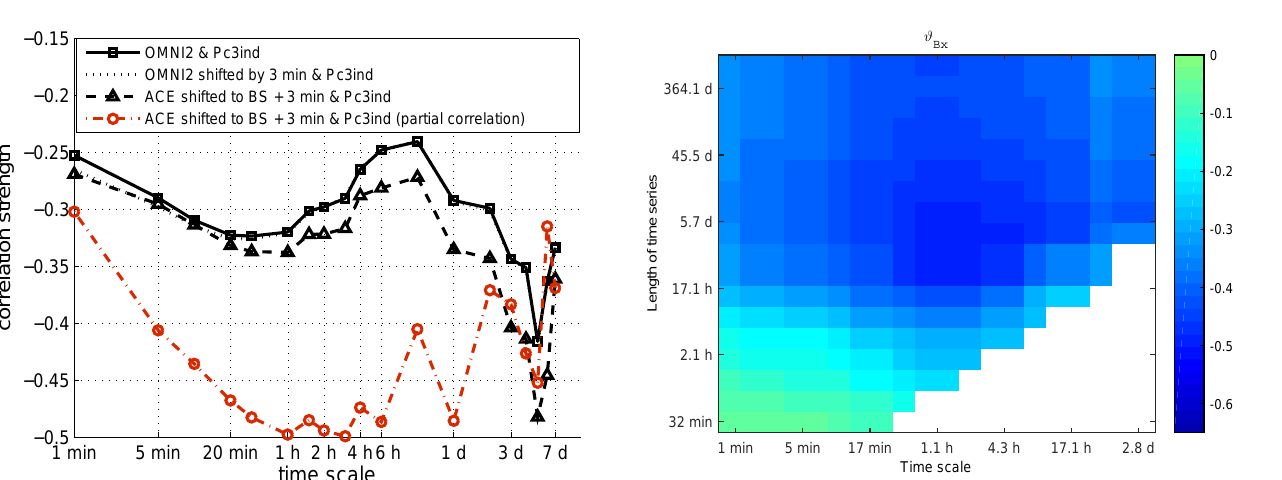
Figure 6. Correlation between Pc3 ind and ϑ B timescales, for unshifted and shifted OMNI2 data, shifted ACE data. The red line shows partial correlation between ACE ϑ B Pc3 ind .